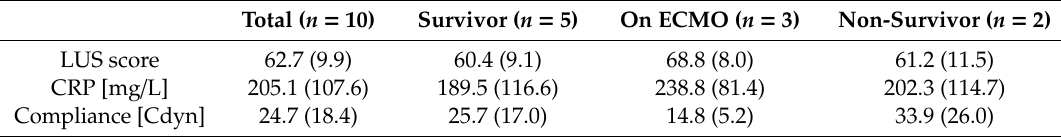
Table 2. Overview of data. “Survivor” defines patients being weaned from veno-venous-extracorporal membrane oxygenation (VV-ECMO), “On ECMO” defines patients still on ECMO at study end, and “Non-survivor” defines patients who died on ECMO. Standard deviations are given in